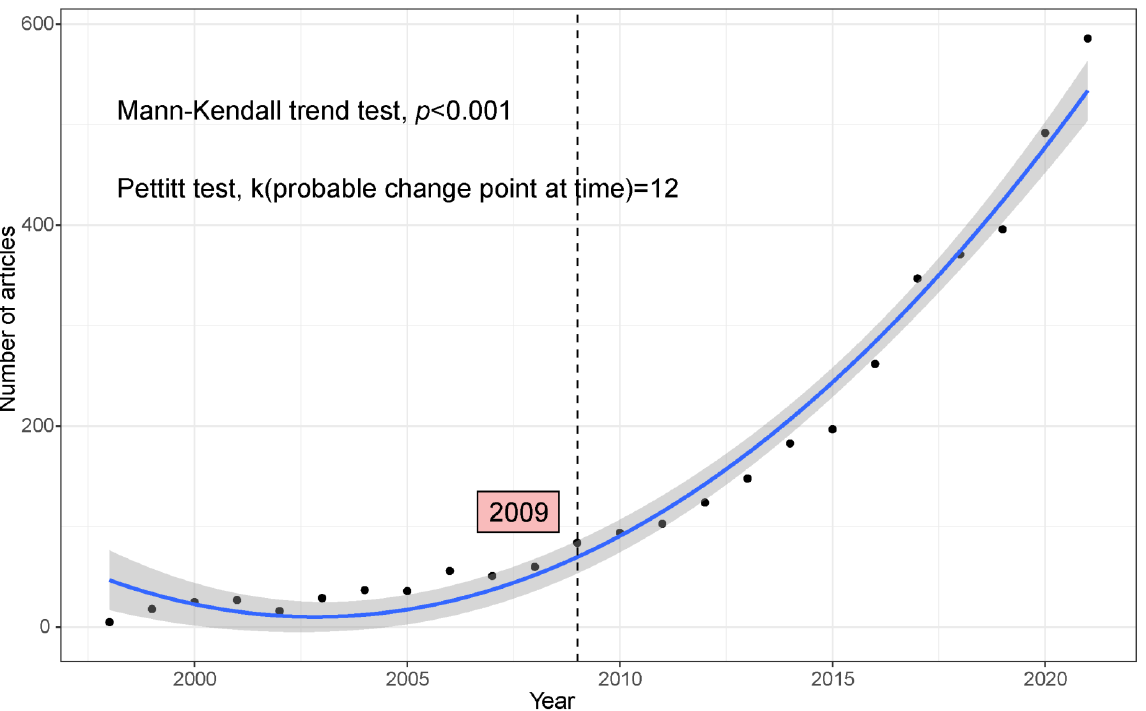
Figure 1. Publication trends and change point of articles based on Mann-Kendall and Pettitt tests. Table 1. Basic features of all the articles.